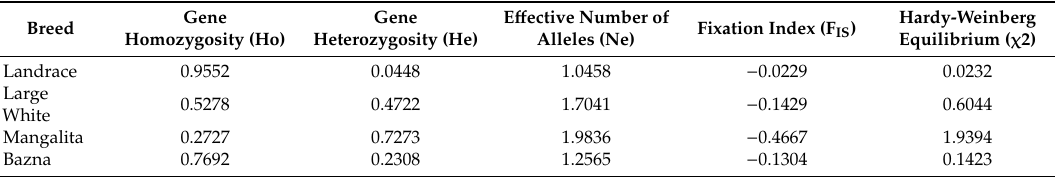
Table 2. Population genetic indexes for CSN2 c.647G > A, within the investigated populations.